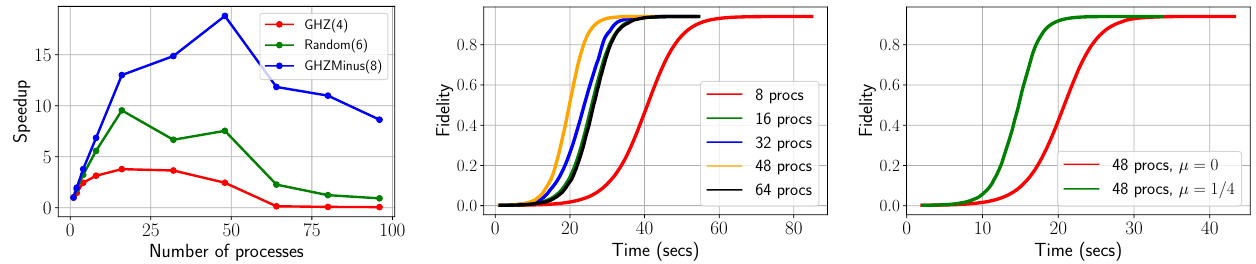
Figure 7. Left panel : Scalability of our approach as we vary the number p of parallel processes. Middle panel : Fidelity function versus time consumed for different number of processes p . Right panel : The effect of momentum for a fixed scenario with Hadamard ( 10 ) state, p = 48, and varying momentum from µ = 0 to µ = 1 4